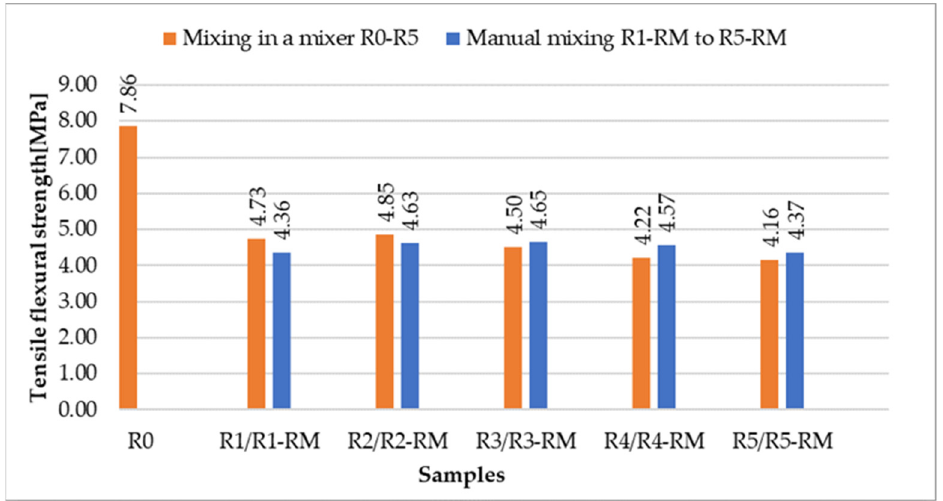
Figure 11. Comparison of flexural strengths after 28 days for samples mixed in a mixer and mixed manually.